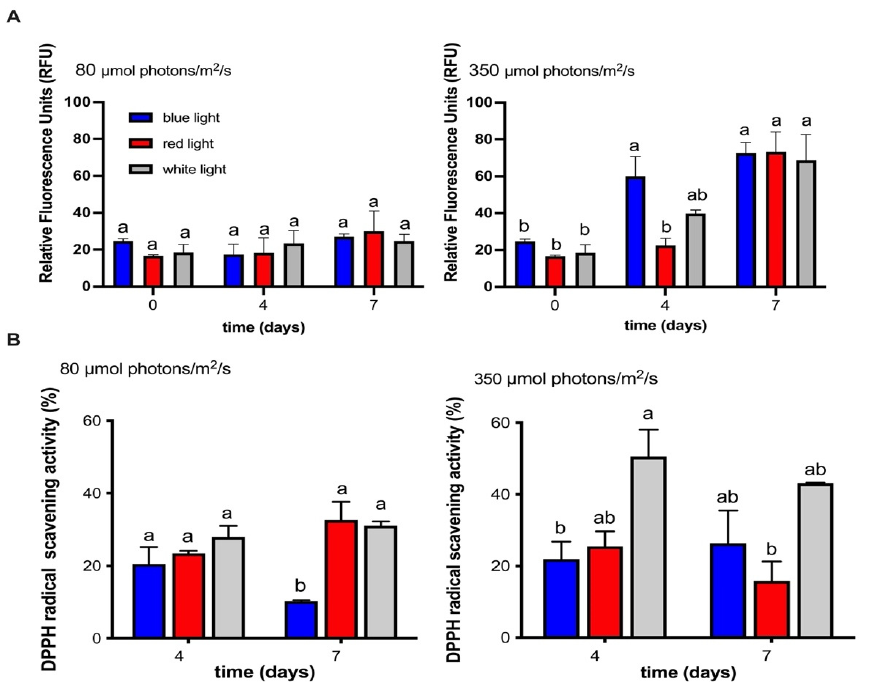
Figure 6. ( A ) Relative Fluorescence Units (RFU) of the MCH-35 microalgae on days 0, 4, and 7 cul- tivated under irradiances of 80 and 350 µmol photons/m 2 /s and different light wavelengths ( red, blue, and white). ( B ) Percentage of DPPH inhibition with the microalgal extract (10 mg/mL) of MCH-35 cultivated under irradiances of 80 and 350 µmol photons/m 2 /s and different light wave- lengths (red, blue, and white). Each bar represents the average of four independent measurements. Statistically different values ( p = 0.05, ANOVA two way, with Tukey posthoc test, n = 3) are indicated by a different letter for each irradiance condition.